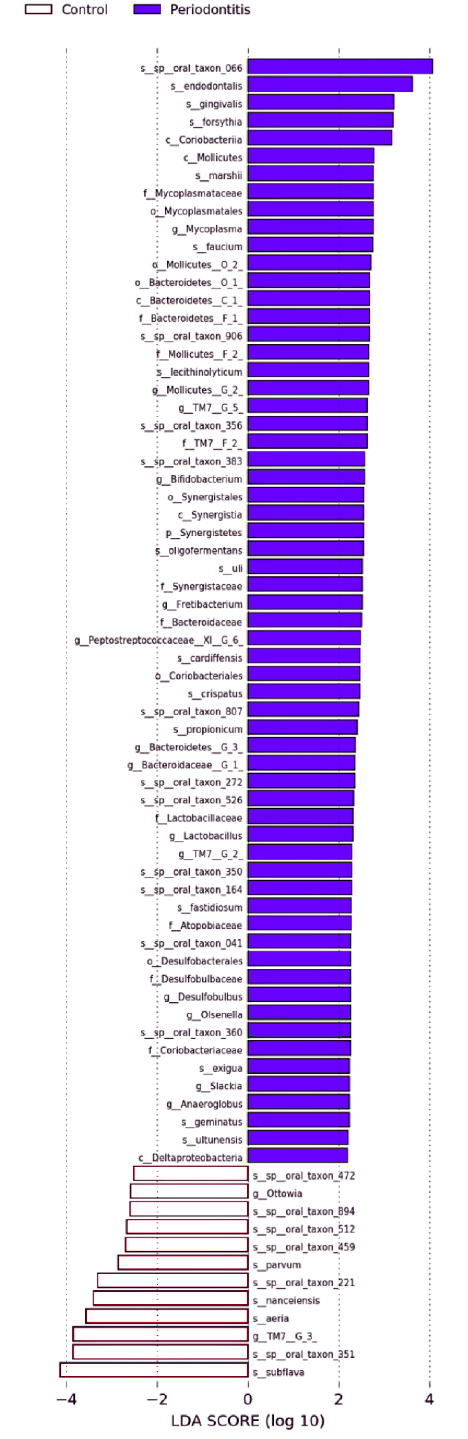
Figure 3. Graphics of linear discriminant analysis (LDA) effect size (LEfSe) for the periodontitis and control groups. Horizontal bars show the effect size for each taxon. The length of the bar indicates the log10 transformed LDA score, indicated by vertical dotted lines. The threshold on the logarithmic LDA score for discriminative features was set to 2.0. The taxon of bacteria with significant change in relative abundance ( n = 74, linear discriminant analysis, p < 0.05) is written alongside the horizontal lines. The name of the taxon level was abbreviated as follows: p, phylum; c, class; o, order; f, family; g, genus; and s, species.